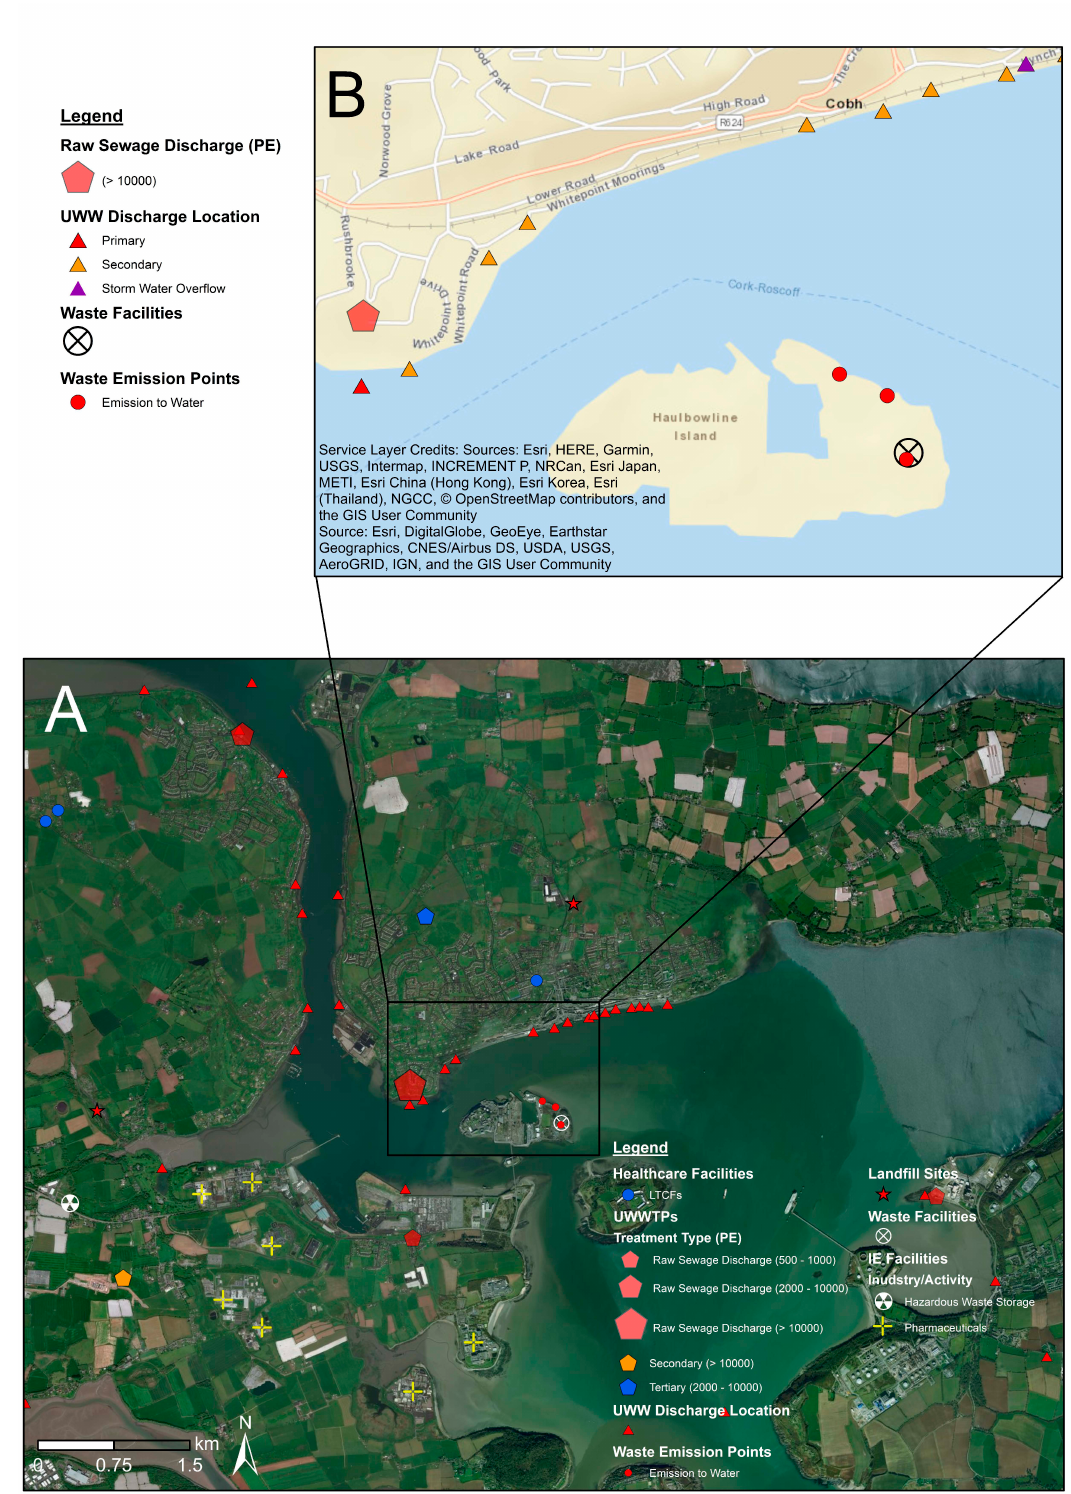
Figure 7. Zoom-in example on a potential sample area using service base map layers (satellite imagery and street map elements) in Cork Harbour. Notes: ( A ) High resolution (fine-scale) map of Cork Harbour including potential ARO sources (classified), healthcare facilities, and satellite imagery base map. ( B ) Zoom-in of Cork Harbour using street map elements base map. UWWTPs = urban wastewater treatment plants. UWW = urban wastewater. IE = industrial emissions. PE = population equivalent (i.e., estimated population served by